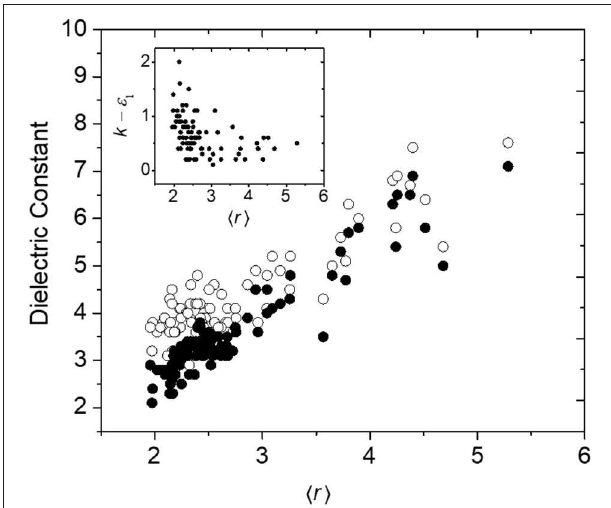
FIGURE 7 | High- ( ε 1 , 4.6 × 10 14 Hz, •) and low- ( k , 100kHz, ◦ ) frequency relative permittivity as a function of h r i for a-BC:H films. The inset displays the difference between k and ε 1 as a function of h r i